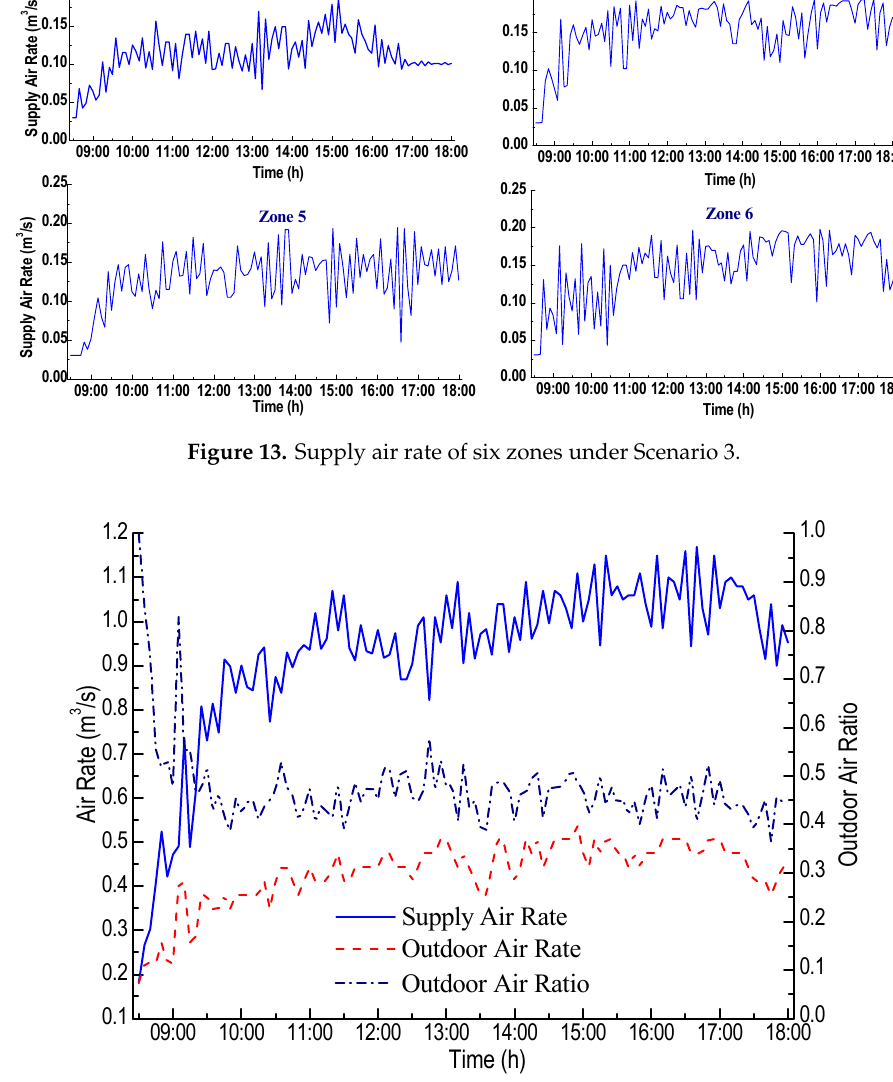
Figure 14. The supply air rate and outdoor air rate of the AC system under Scenario 3.